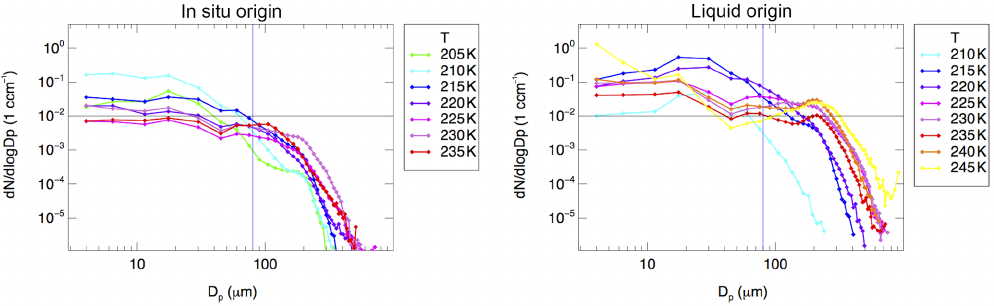
Figure 10. Particle size distributions of in situ origin cirrus (left) and liquid origin cirrus (right) for 5K temperature bins. The temperatures listed in the key are the middle of the temperature bin. D p : optical equivalent diameter for CAS-DPOL, area equivalent diameter for CIP- Grayscale ( D p >